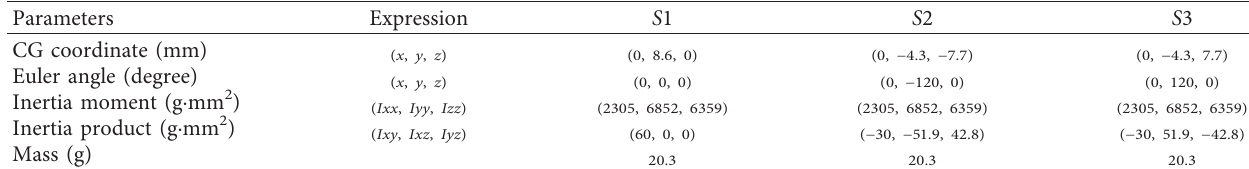
Table 2: Main properties of